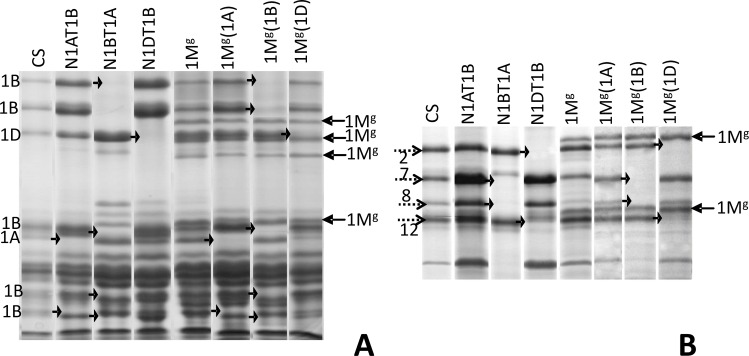
Seed storage protein profile of CS, DAL1Mg and DSLs.A- Gliadins, B-HMW-GSs. Nulli-tetra lines were used for comparison. New subunits are indicated by arrows and deleted subunits by arrowheads.